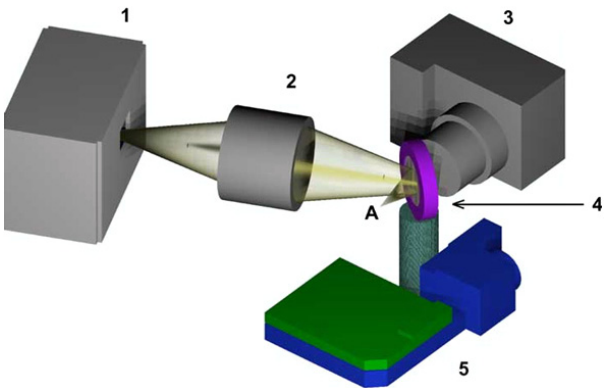
Fig. 1. Scheme of custom designed 2D spectral imager. 1 – spectrometer part with plane actuators, 2 – lens, 3 – digital camera, 4 – semitransparent mirror, 5 – focal plane actuator and A – sample.